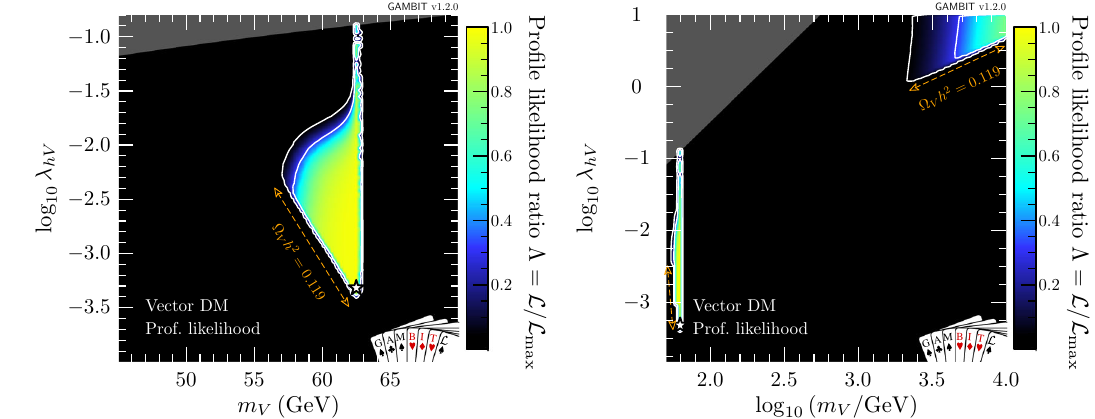
Fig. 1 Profile likelihood in the ( m V ,λ hV ) plane for vector DM. Con- tour lines show the 1 and 2 σ confidence regions. The left panel gives an enhanced view of the resonance region around m V ∼ m h / 2. The right panel shows the full parameter space explored in our fits. The